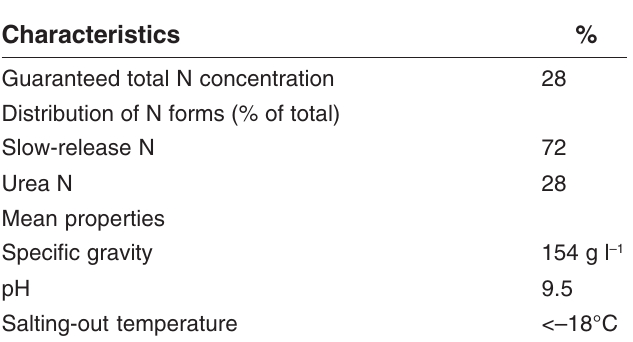
N-SURE Technical Information